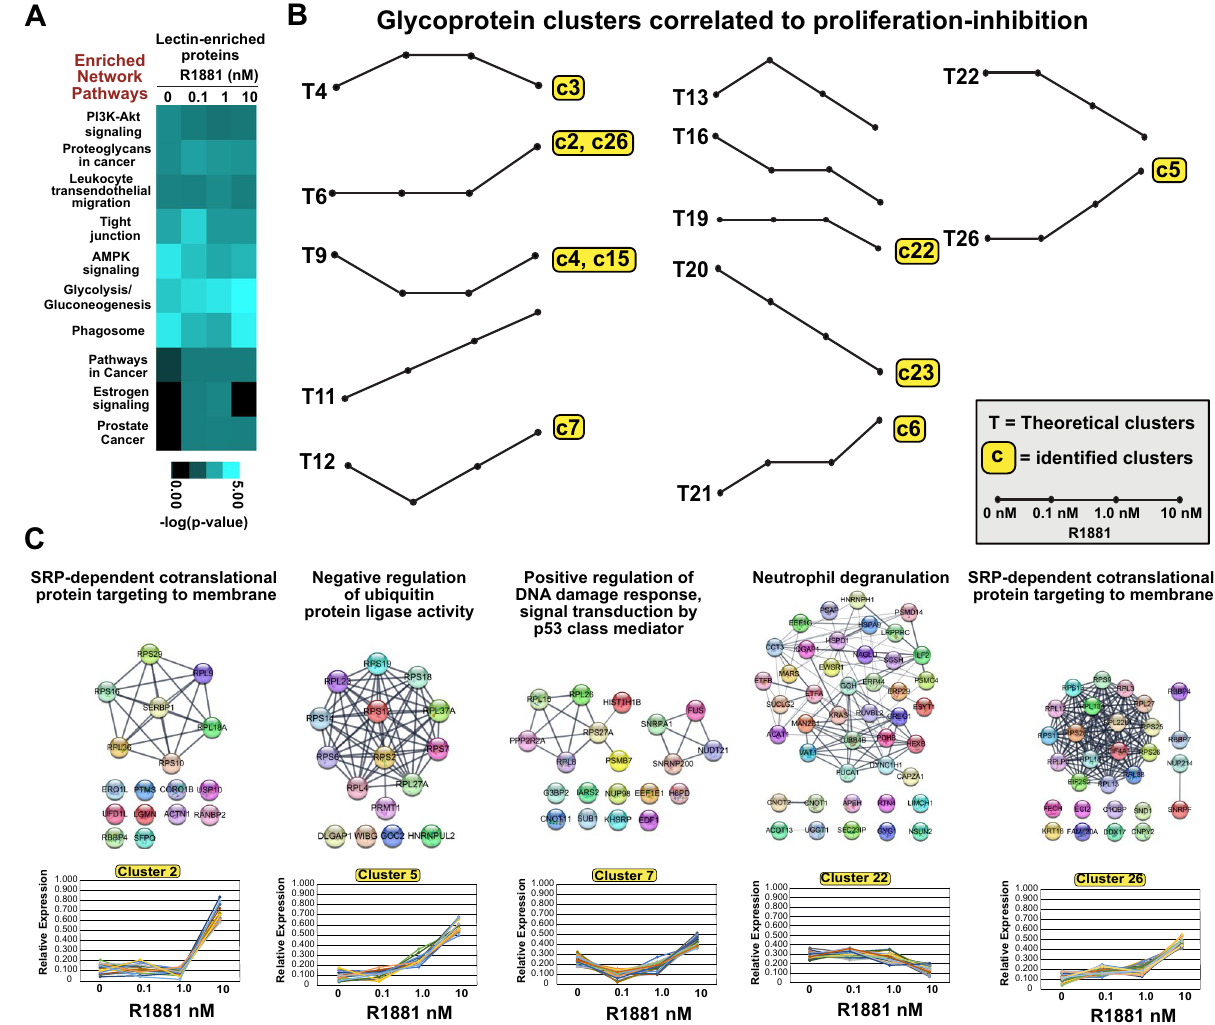
Figure 2. Bioinformatic analyses of glycoproteome. ( A ) Heat-map visualization of the ten top-ranked glycoprotein pathways in androgen- vs. vehicle-treated samples. The WebGestalt bioinformatics program and KEGG pathway analysis were used. Enriched network pathways and computed p -values < 0.05 are reported as –log ( p -value). Data were transformed using the TreeView software. ( B ) Theoretical clusters and clusters identified in the context of growth inhibition at 10 nM androgen. Of 27 theoretical protein clusters, 10 were found to be increased or decreased in samples treated with 10 nM vs. 1 nM R1881-treated samples. ( C ) STRING protein–protein interactions in six clusters of proteins ( i.e. , cluster 2, 5, 7, 14, 22, and 26) enriched for biological processes as determined by the WebGestalt overrepresentation enrichment analysis (OEA) program. Protein interaction networks were constructed and visualized in Cytoscape using the STRING plug-in application. Each cluster is annotated with the top-ranked enriched biological process above its PPI